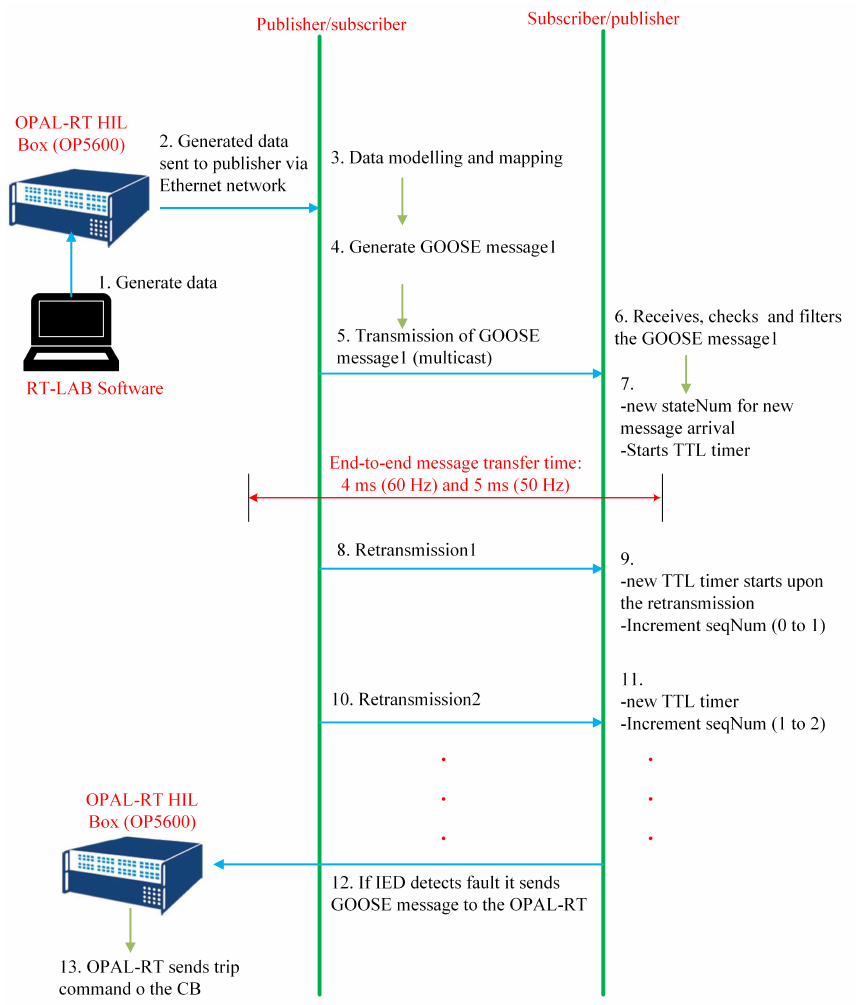
Figure 5. Data flow of the GOOSE protocol without IEC